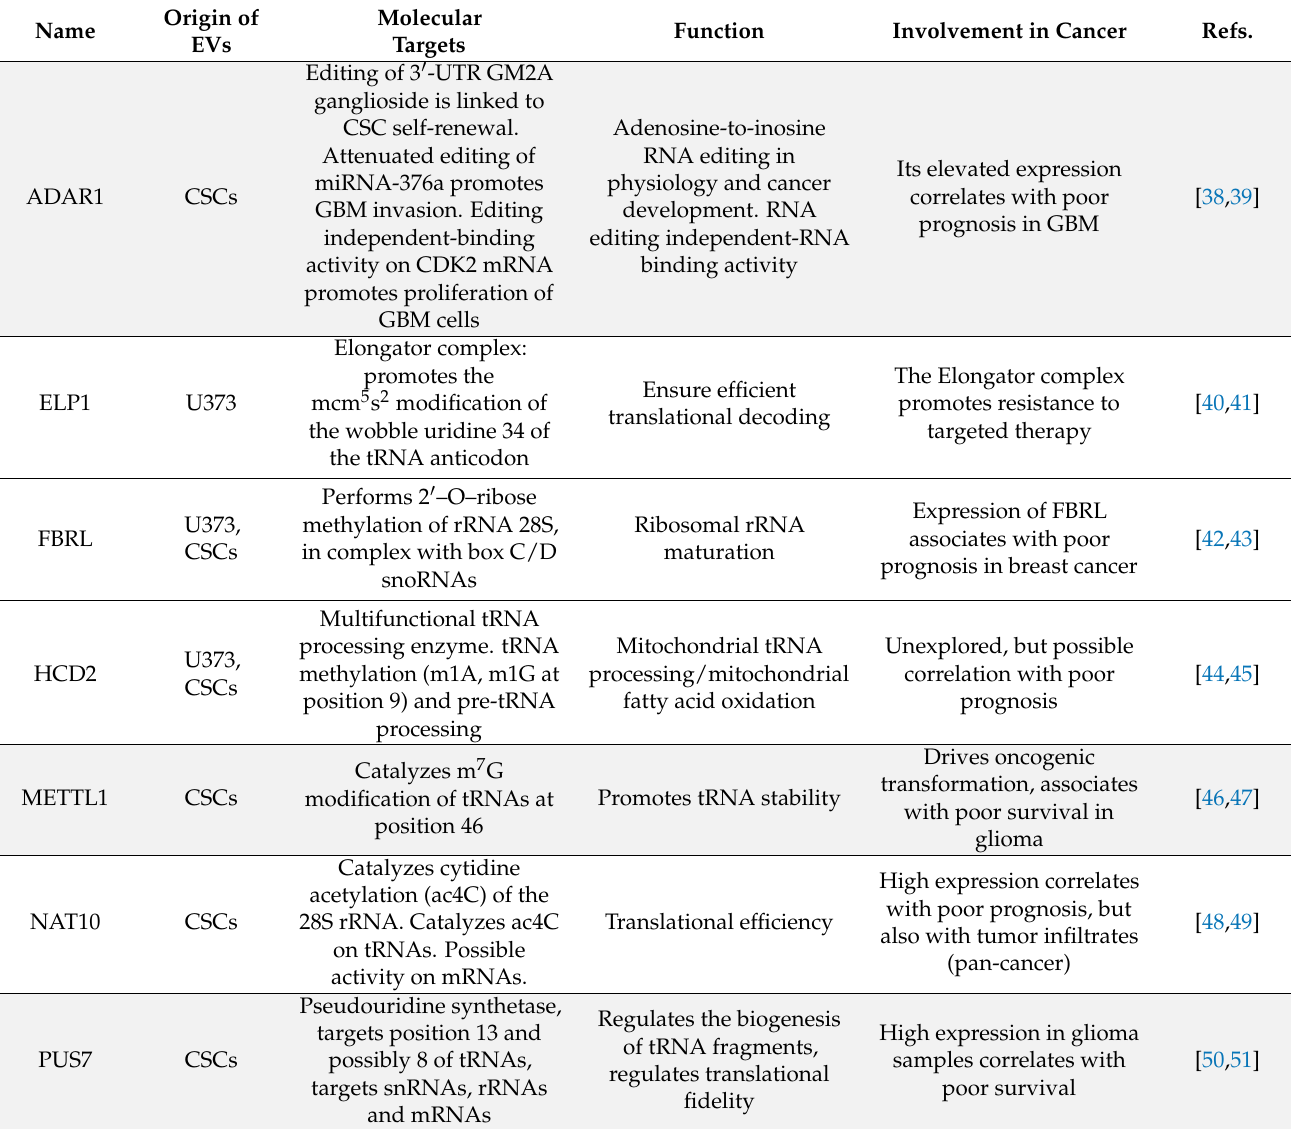
Table 3. RNA-modifying enzymes found in our GBM- and